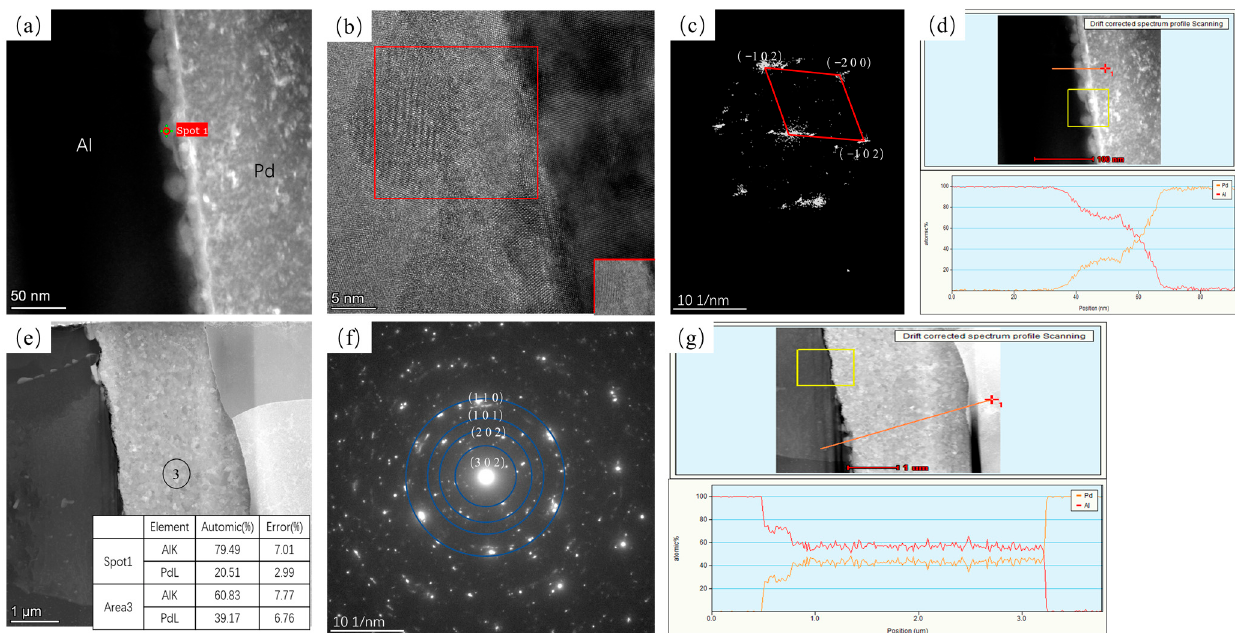
Figure 7. TEM plots of Pd/Al composite wires annealed at 300 °C for different times and their SEAD plots. ( a ) HAADF plot at 5 s, ( b ) high-resolution plot of spot 1 in ( a , c ) FFT transform of the red region in ( b , d ) EDS line sweep at 5 s, ( e ) HAADF plot at 1080 s and EDS results for each position, and ( f ) SAED plot of spot 3 in ( e , g ) EDS line sweep at 10,800 s.